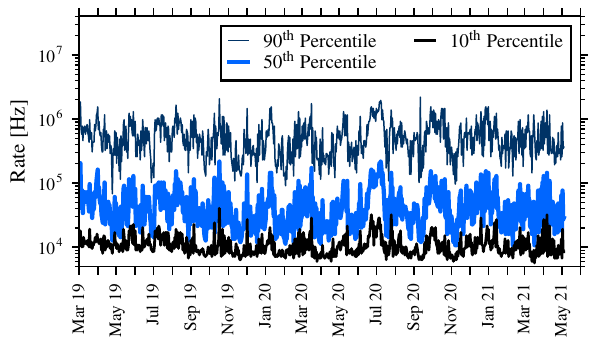
Fig. 13 Daily percentiles of the background rates over 2 years of STRAW operation. A detailed investigation of the long-term biolumi- nescence monitoring will be the subject of a future